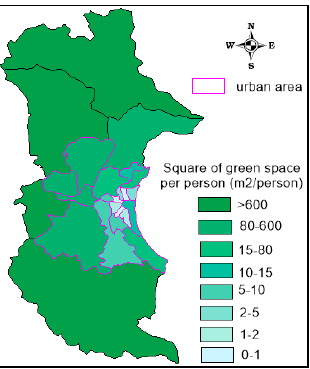
Figure 3. Distribution of UGS index in urban core of Nha Trang city in